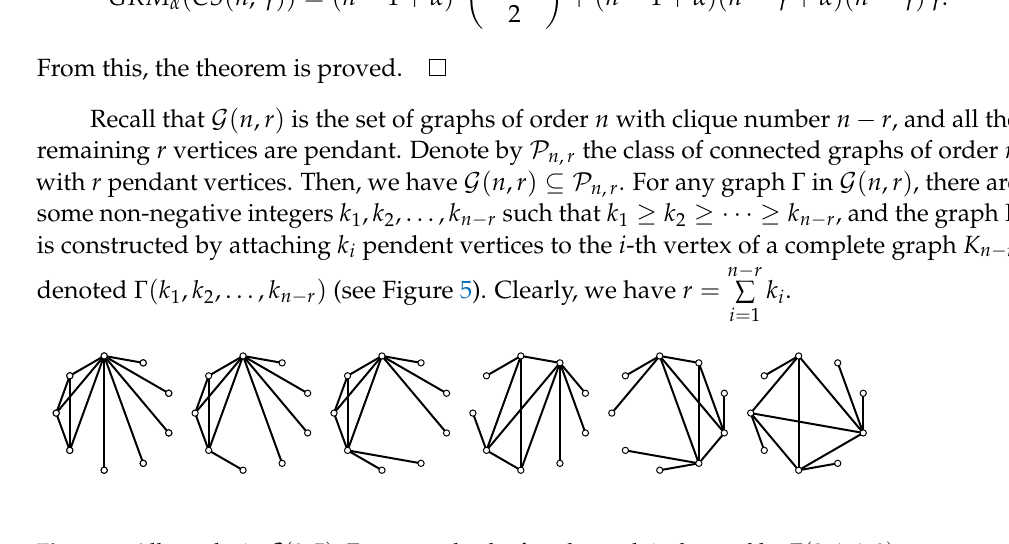
Figure 5. All graphs in G ( 9,5 ) . For example, the fourth graph is denoted by Γ ( 3,1,1,0 )